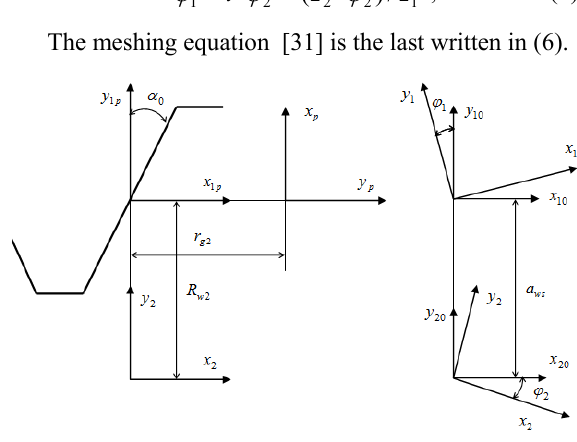
Figure 4. Coordinate systems to define elements of matrix )(~ ϕ 22,1